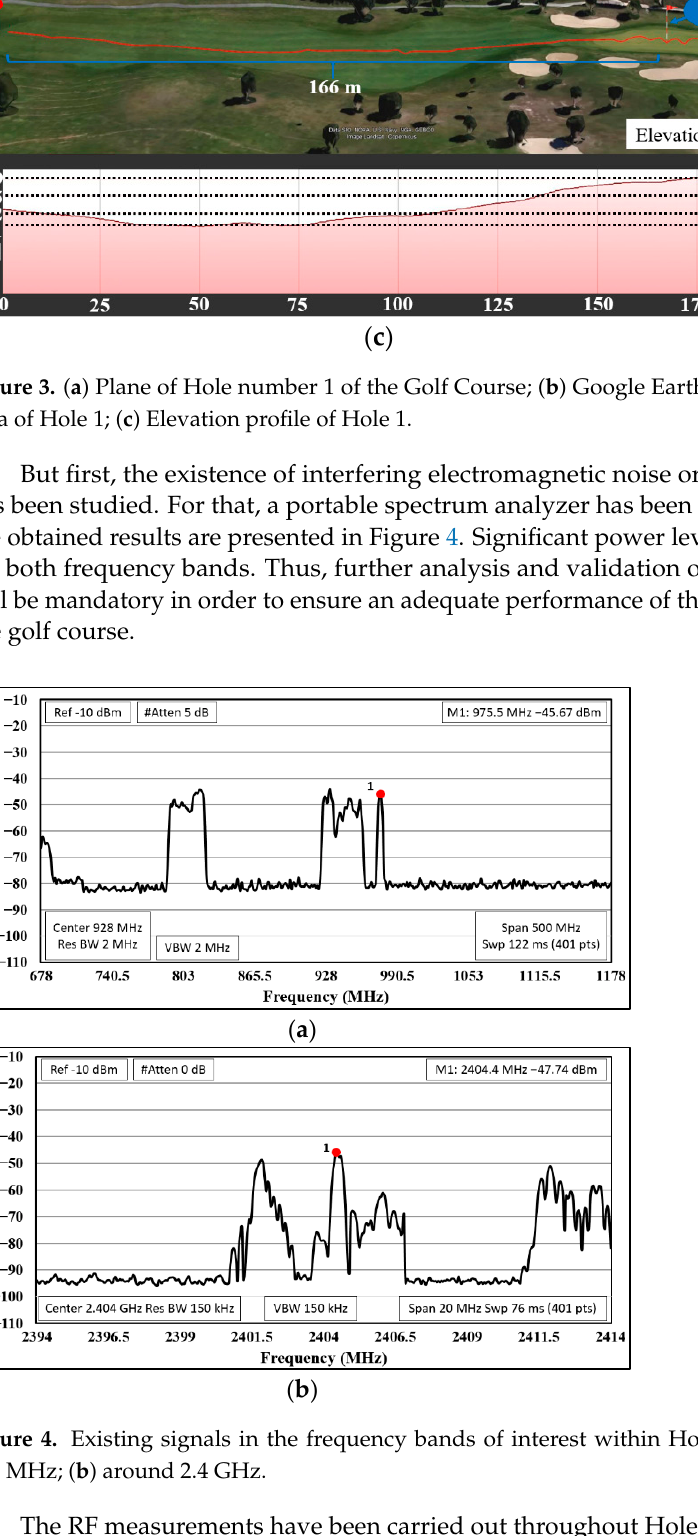
Figure 4. Existing signals in the frequency bands of interest within Hole number 1: ( a ) around 900 MHz; ( b ) around 2.4 GHz.